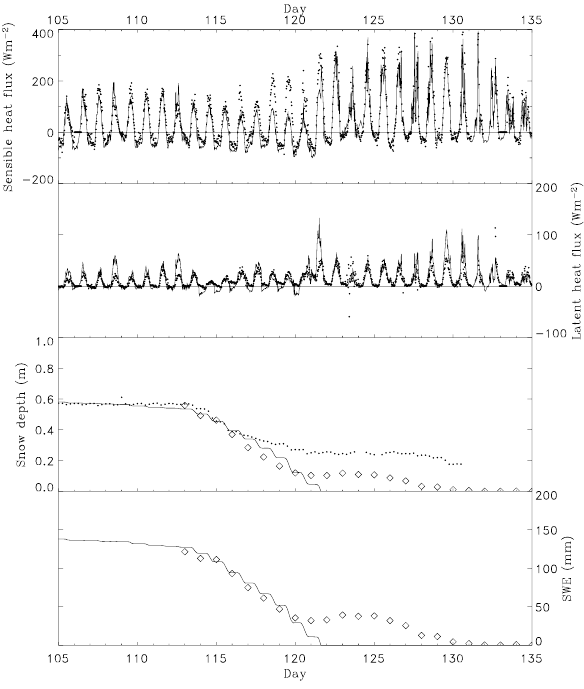
Fig. 7. As Fig. 6, but for the valley site in 2003. Fig. 8. As Fig. 6, but for the plateau site in 2004.